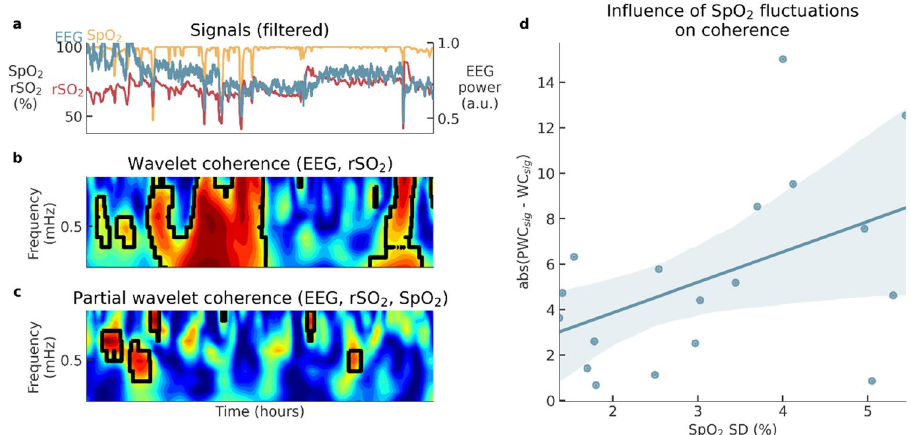
Figure 2. Comparison of regular wavelet coherence and partial wavelet coherence. ( a ) Input signals are smoothed with a 5-min moving average to correspond with the frequency range illustrated in the wavelet coherence. ( b ) Regular wavelet coherence between EEG and rSO2. ( c ) Partial wavelet coherence removes the influence of the SpO2 signal. Regions with significant coherence are encapsulated by black contours. ( d ) The relationship between variability (standard deviation) of SpO2 and the difference between regular wavelet coherence and partial wavelet coherence (percentage of significant coherence).